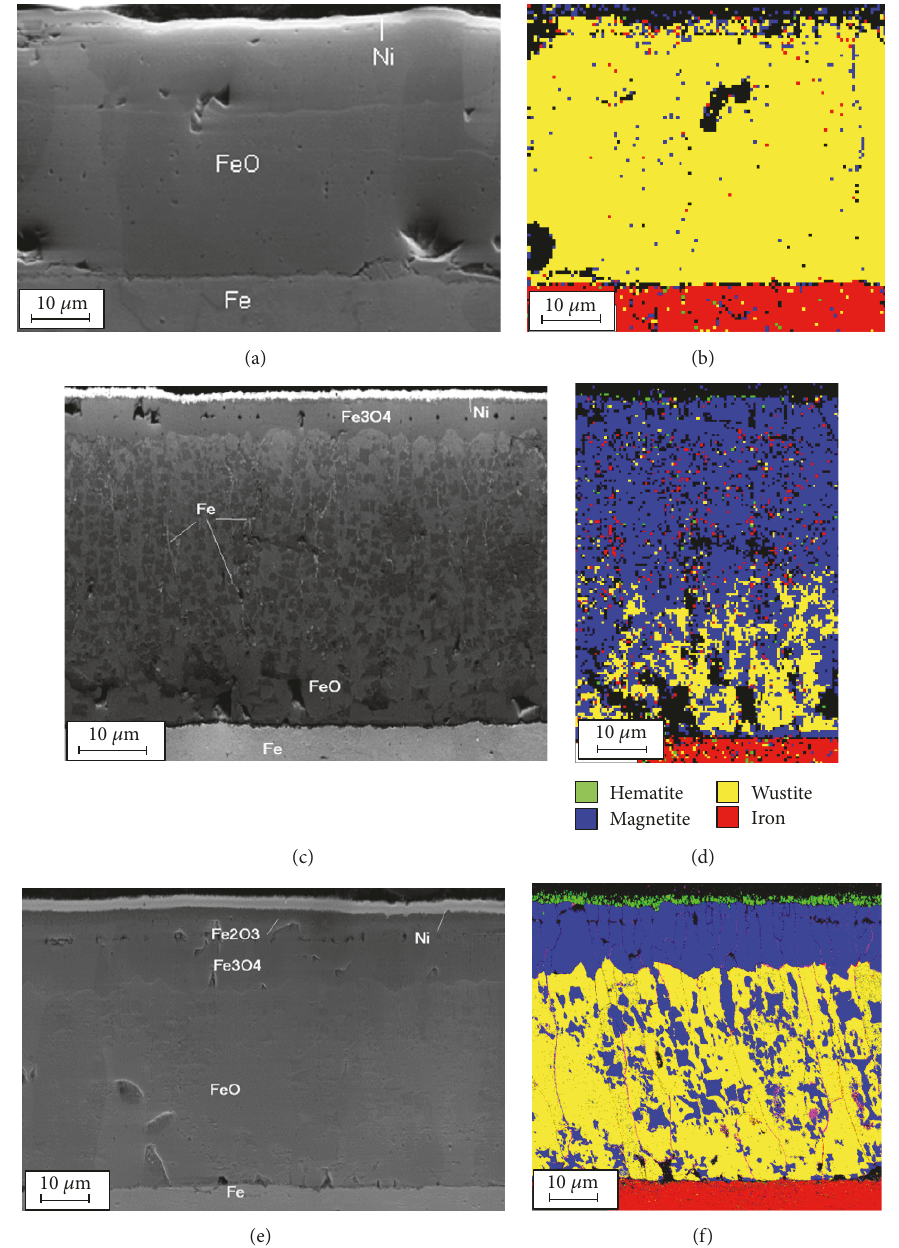
Figure 2: SEM images (black and white) and EBSD phase maps (color) on cross sections on the different oxide scale samples where a and b are on wustite, c and d are on magnetite, and e and f are on